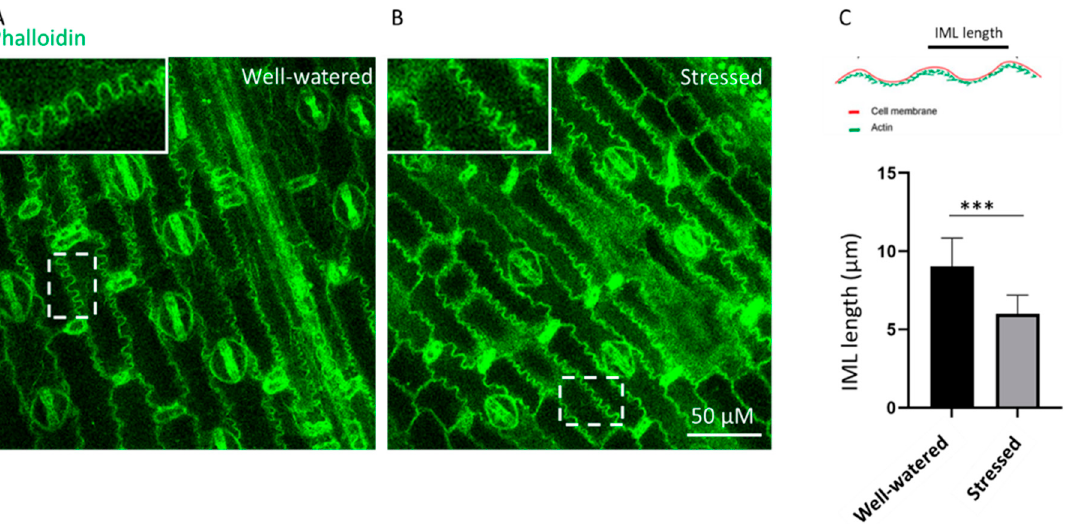
Figure 7. Microscopic images of phalloidin-stained sorghum from well-watered conditions ( A ) vs. early vegetative drought-stressed conditions ( B ). Quantification of the length of the IML in well- watered and drought-stressed sorghum ( C ). Data are means ± SD (n = 30 (10 cells)), *** p < 0.001.